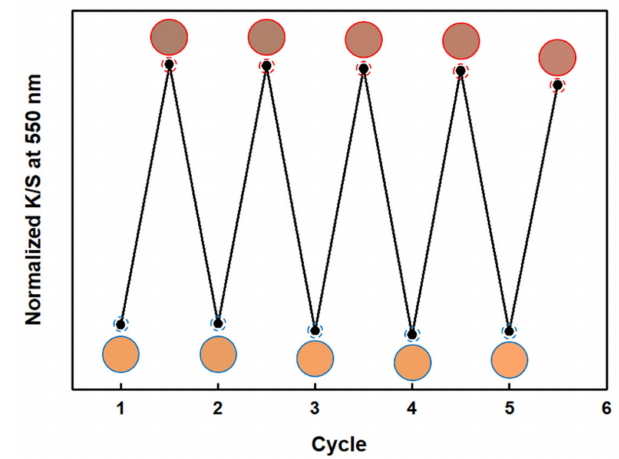
Figure 9. Reversibility of the fabricated textile sensor with HCl gas: ( blue circle ) before exposure; ( red circle ) after exposure.